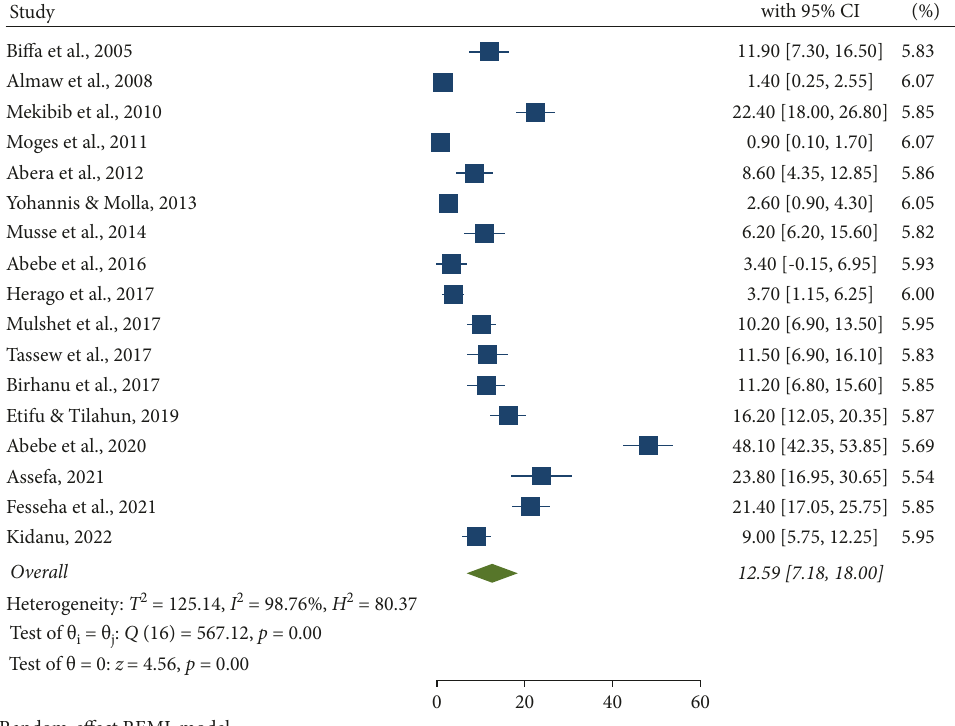
Figure 7: Pooled prevalence of clinical mastitis among dairy cows from 2005 to 2022.